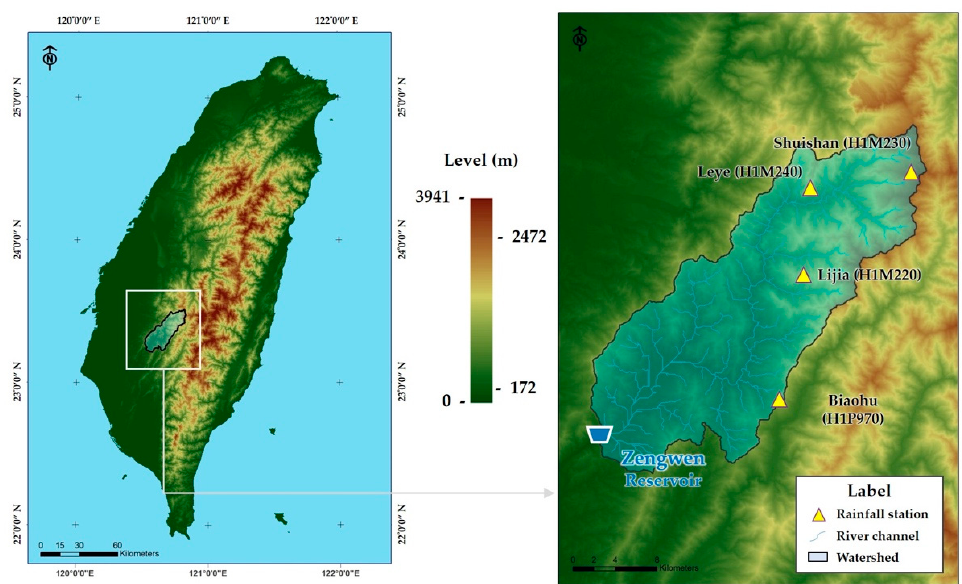
Figure 3. Geographical location of the watershed and rainfall stations of Zengwen Reservoir (made by this study).